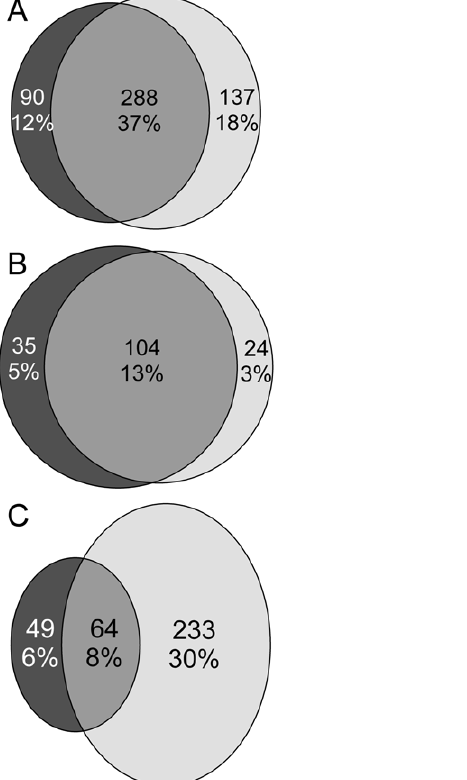
Figure 4. Subject overlaps between different subgroup iden- tification methods. A: Subject overlap between the low HDLc subgroup (dark circle) and the sum of lipoprotein profile-based cluster 2 and 3 (light circle). Figures indicate the number of subjects in each group, in absolute numbers and as percentage of the total study population. B: Subject overlap between the high baseline-triglyceride subgroup (dark circle) and lipoprotein profile-based cluster 3 (light circle). Figures indicate the number of subjects in each group, in absolute numbers and as percentage of the total study population. C: Subject overlap between the medium baseline-triglyceride subgroup (dark circle) and lipoprotein profile-based cluster 2 (light circle). Figures indicate the number of subjects in each group, in absolute numbers and as percentage of the total study population. Lipoprotein cluster 2 clearly identifies a larger group of fibrate responders than the medium baseline-TG group.